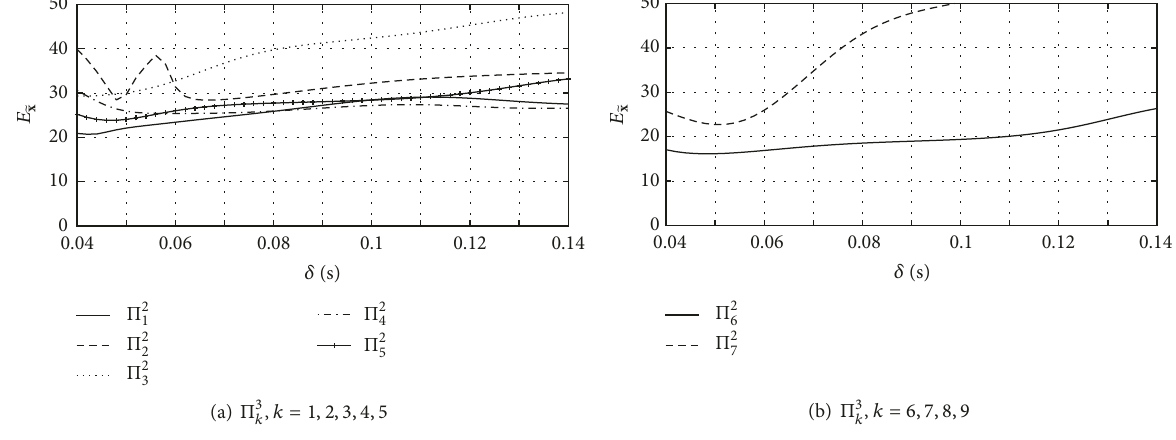
Figure 11: Function 𝐸 ̃ x (𝛿) computed with two instrumented floors.